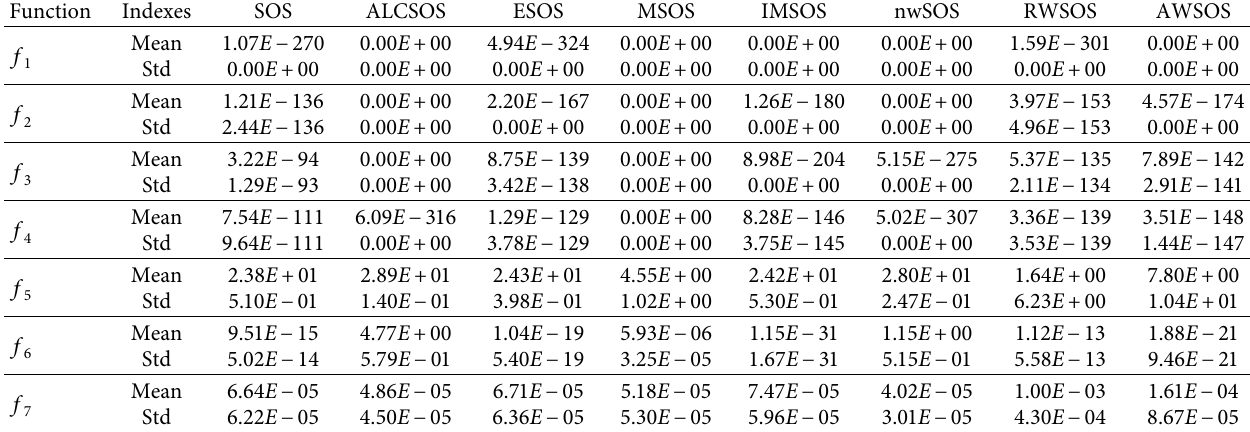
Table 11: Results of the SOS and variants on unimodal functions.